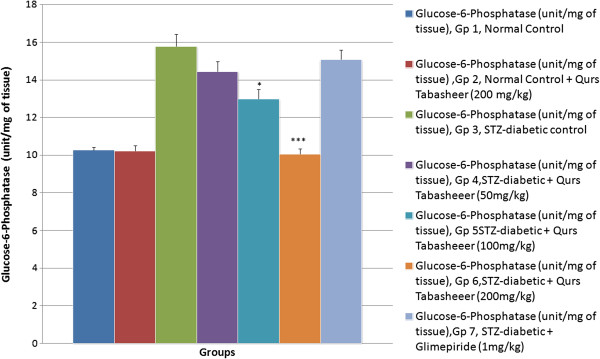
Effect of Qurs Tabasheer on level of glucose-6-phosphatase at different concentrations on normal and STZ induced diabetic rats, compared to standard drug Glimepiride; values are mean ± SEM; n = 6; *P < 0.05; **P < 0.01; ***P < 0.001; P > 0.05 is considered as non-significant (ns).